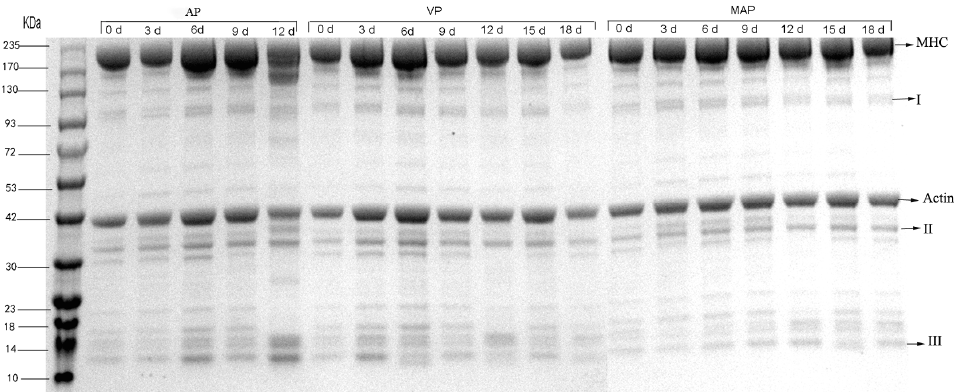
Figure 8. Effects of three packaging methods (AP, VP, and MAP) on total protein degradation of grouper samples during refrigerated storage at 4 °C. (AP: air packaging; VP: vacuum packaging; MAP: modified atmosphere packaging).